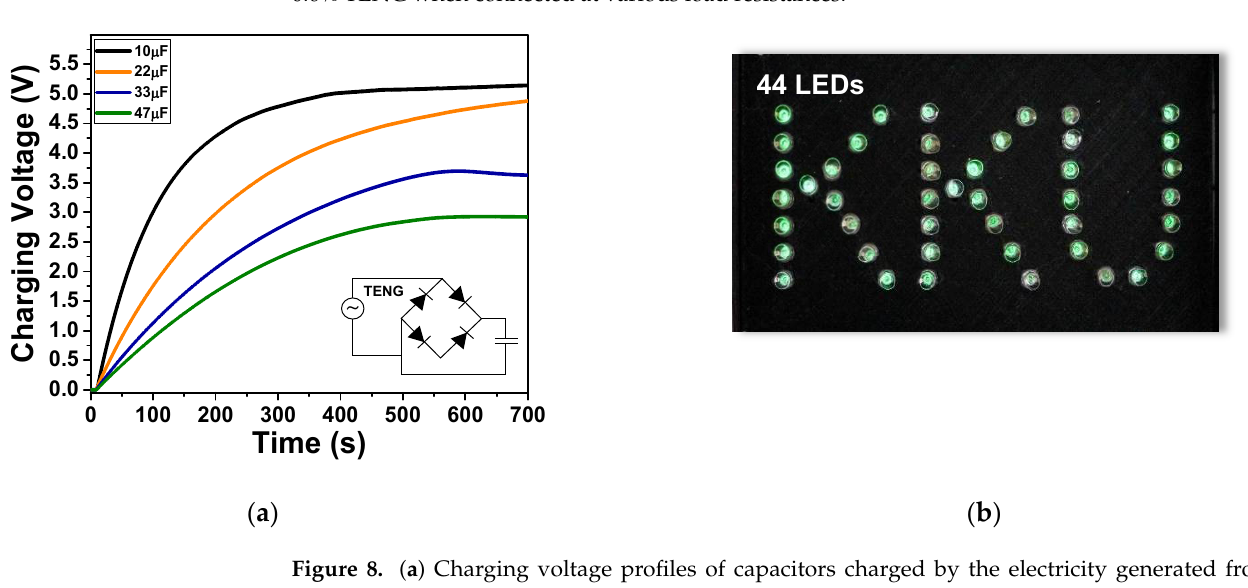
Figure 9. The demonstration of motion sensing application of the fabricated NR-ACH TENG under a single electrode configuration using finger taps and the inset of the generated voltage signal. 4. Conclusions The biodegradable NR-ACH composite was synthesized and used to fabricate a TENG to convert mechanical energy into electricity. The addition of ACH was found to improve the electrical output performance of the TENG due to the high surface areas of the porous structures of ACH filler materials, which also acted as charge trapping sites to intensify triboelectric charges generated during electrification events. The NR-ACH TENG with the optimum ACH concentration of 0.6% generated the highest electrical power density of 242 mW/m 2 , which was almost three times larger than that of the un- modified NR TENG. The generated electrical power was able to charge the commercial capacitors to power small electronic devices. In addition, the NR-ACH TENG, with a sin- gle electrode configuration, was able to detect the movement of the human body, which could be applied to a motion-sensing application.